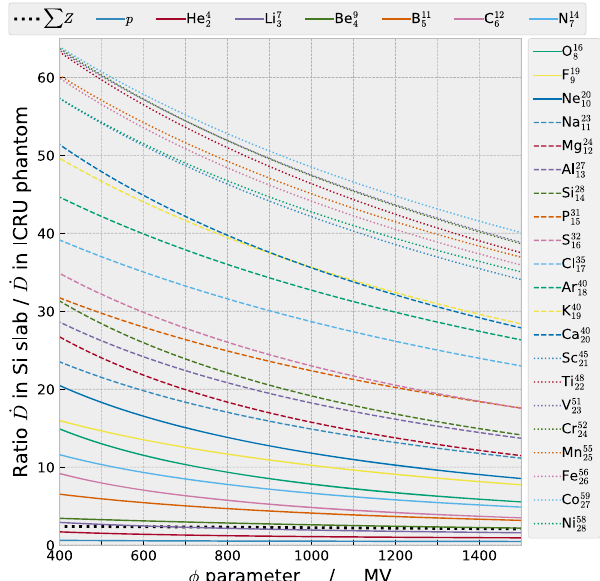
Fig. A4. Conversion factor between Si slab and the ICRU sphere as a function of the / parameter and atomic number Z . The dotted black line indicates the net conversion